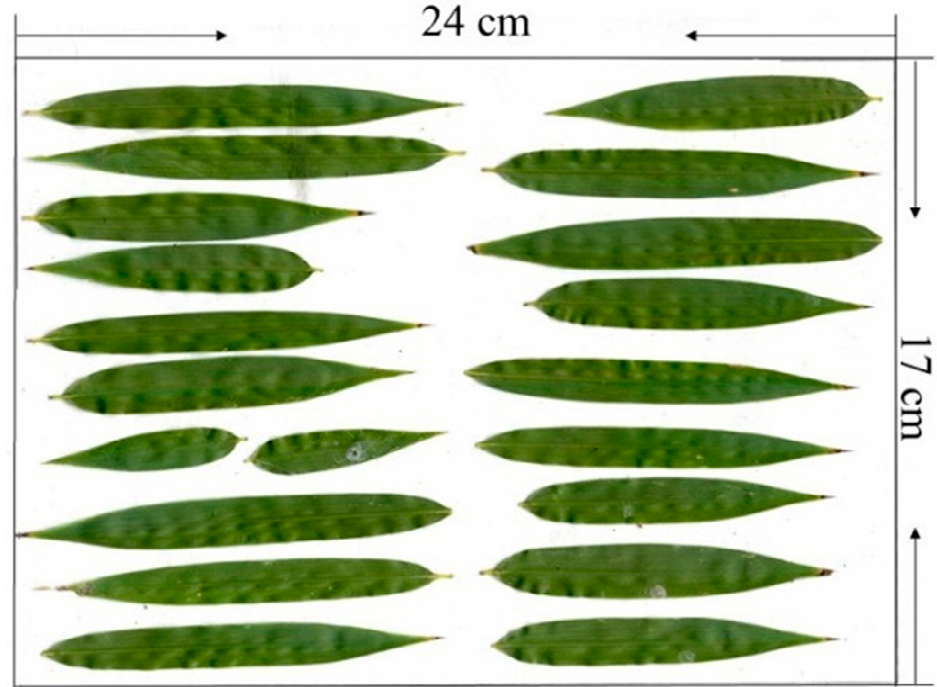
Figure 2. An example of the scanned images of Moso bamboo leaves.